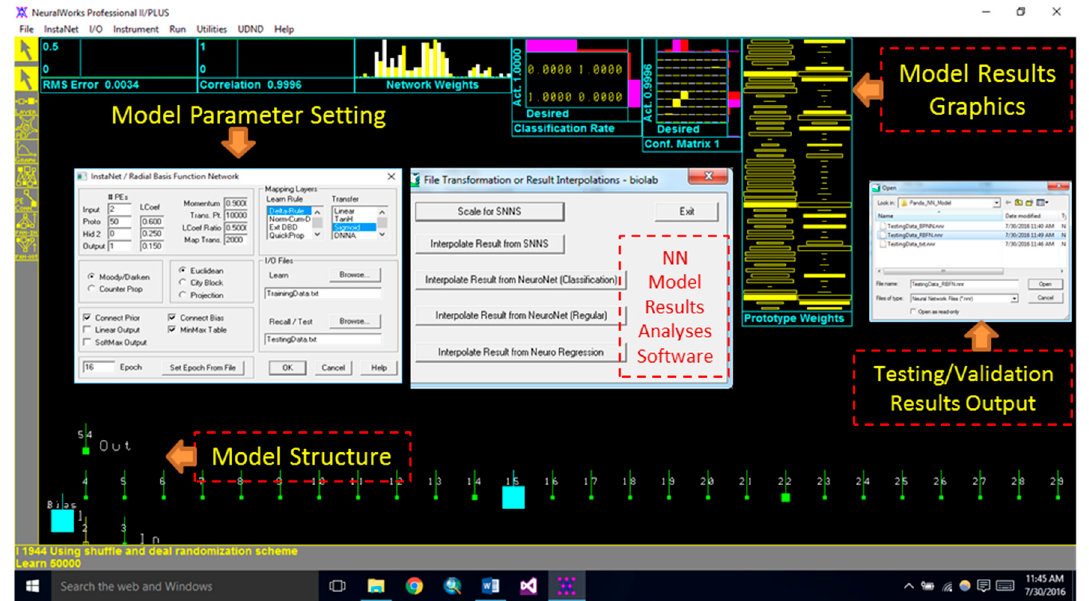
Figure 6. Visual representation of remotely sensed digital information-based ET-estimation RBFN model architecture design, training model output graphics, and validation result interpolation (software) process.